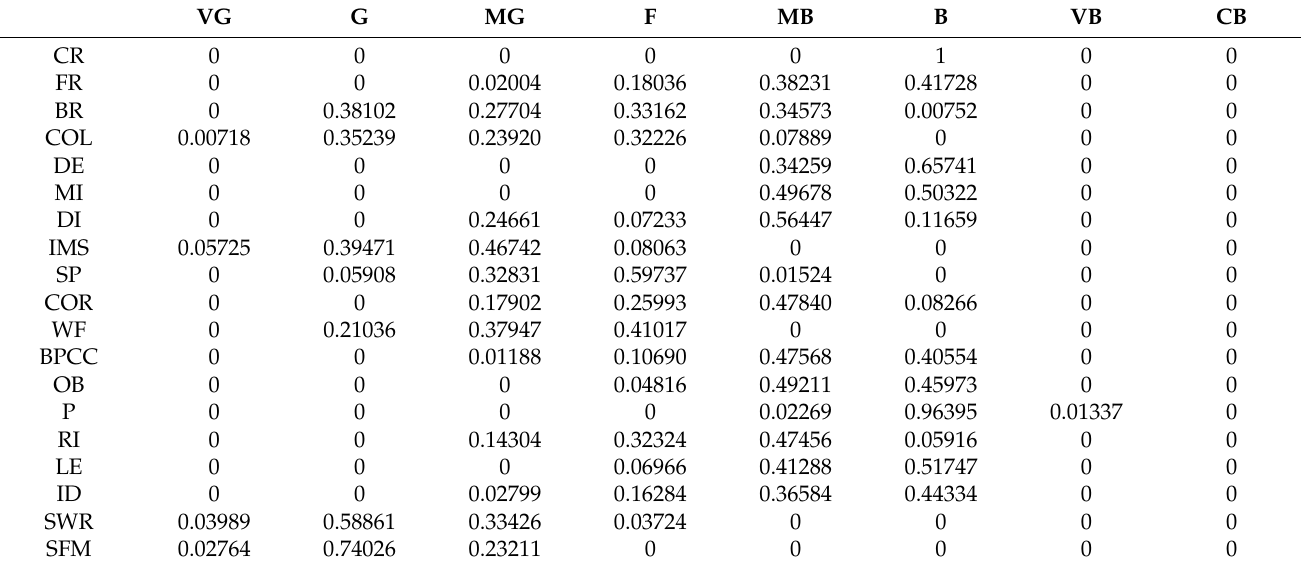
Table 9. Fuzzy weighted ER rule belief degrees for sewer pipeline failures.